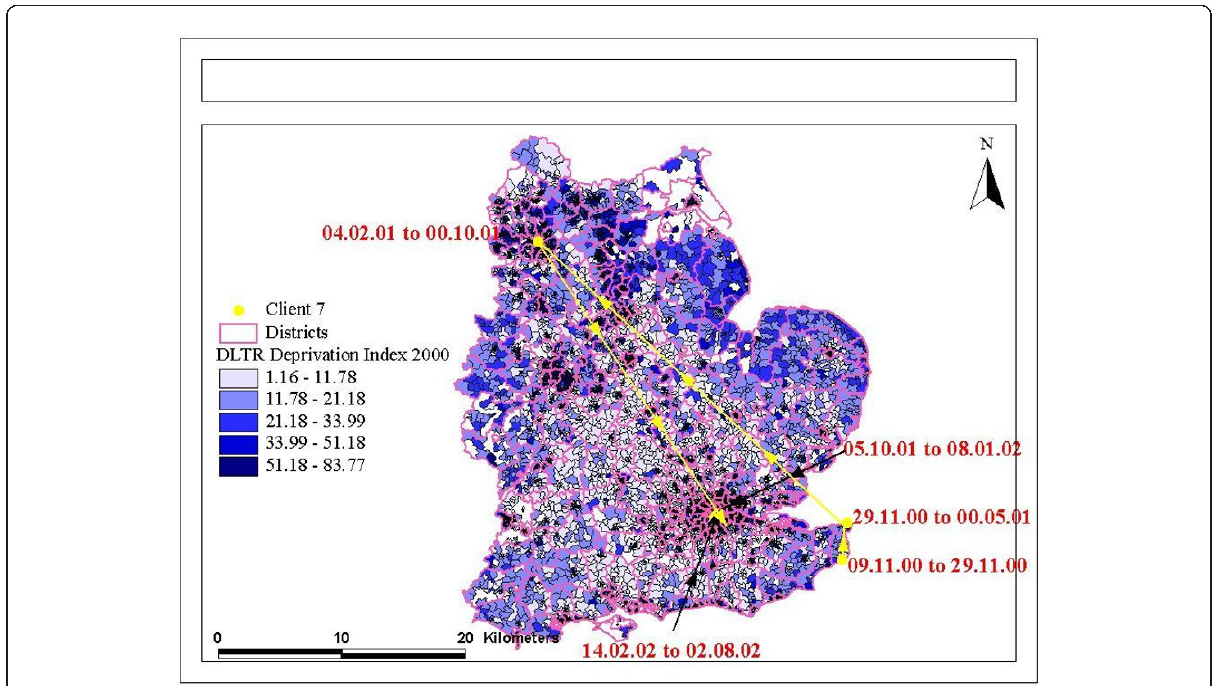
Figure 2 Mapping mobility between different levels of area deprivation